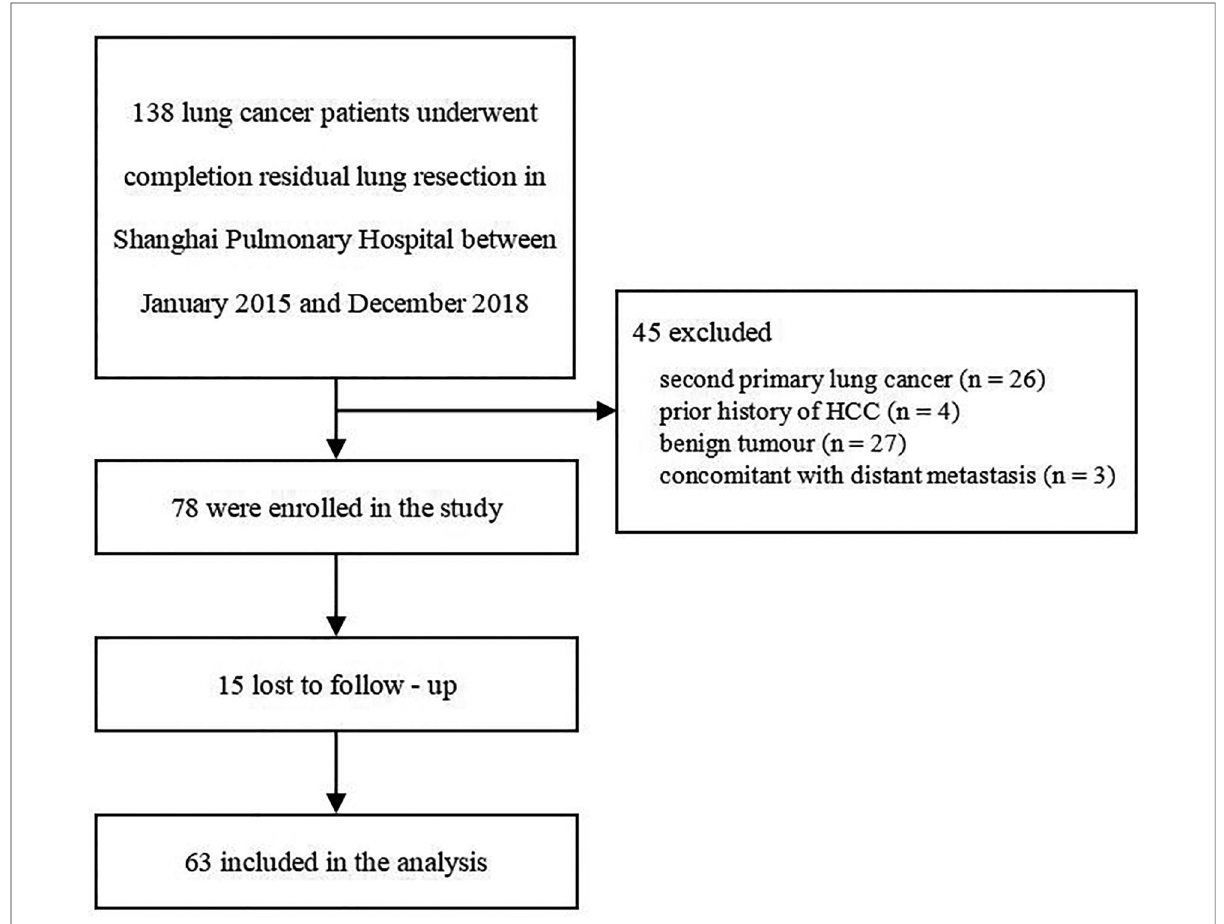
FIGURE 1 Flowchart demonstrating patient inclusion and